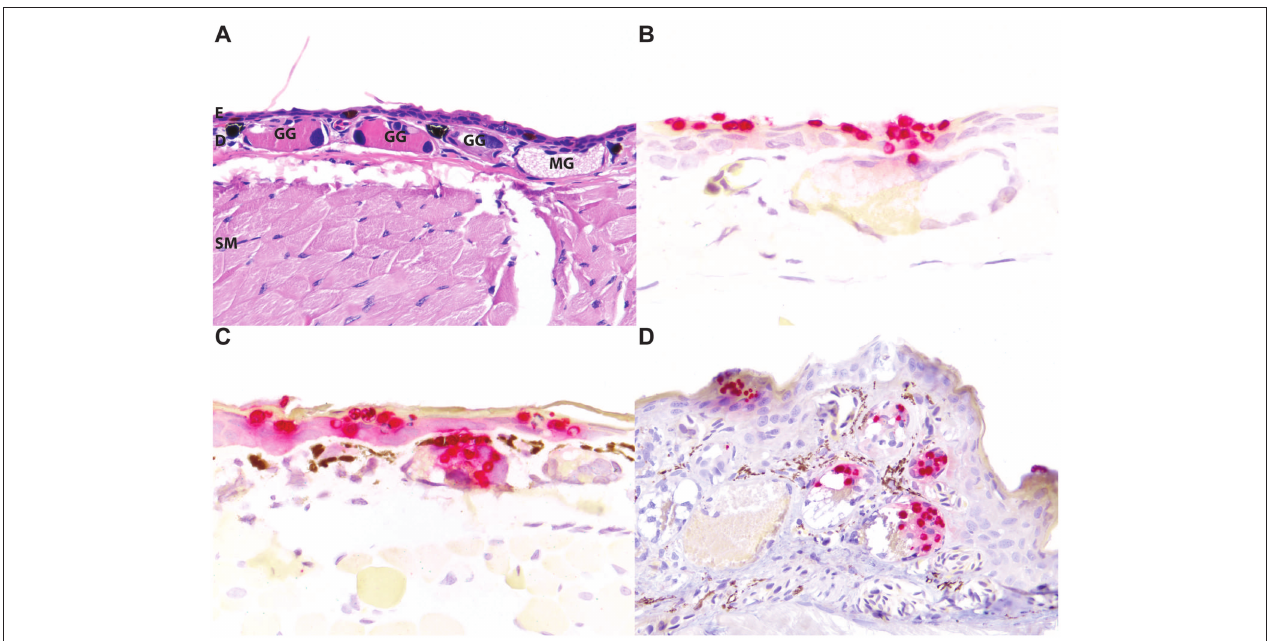
FIGURE 4 | Bsal infection of dermal glandular epithelial cells in salamanders. Normal, uninfected eastern newt ( Notophthalmus viridescens ) skin stained with hematoxylin and eosin highlighting the epidermis [E], dermis [D], dermal glands (granular glands [GG] and mucus glands [MG]), and subcuticular skeletal muscle [SM] (A) . In experimentally infected red salamanders ( Pseudotriton ruber ; B ), yellow-eyed ensatinas ( Ensatina eschscholtzii xanthoptica; C ), and large-blotched ensatinas ( E. e. klauberi ; D ), positive red ISH staining of Bsal organisms extends down from the epidermis into the epithelial cells of dermal glands. In the most severely affected regions, abundant organisms may be present in multiple glands (C) . (A,D) are at 200x magnification; (B,C) are at 400x